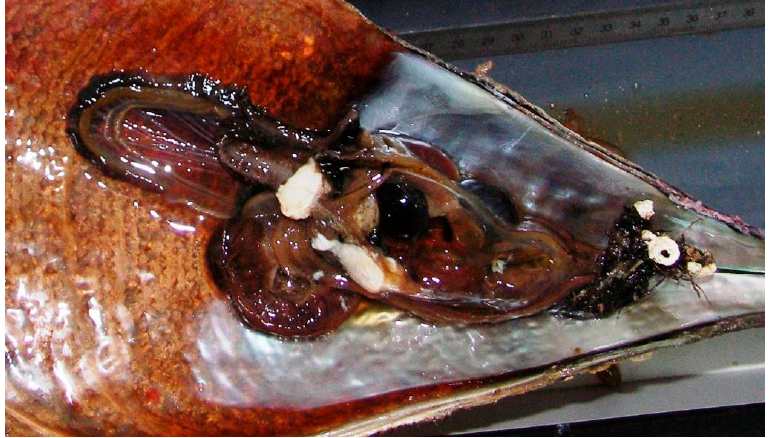
Figure 5. Darker mantle and shrunken soft tissues in a noble pen shell infected by Haplosporidium pinnae.